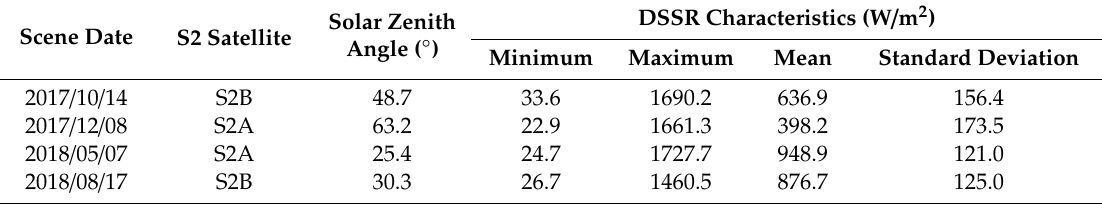
Table 3. Four typical S2 data points and statistical features of the estimated DSSR.